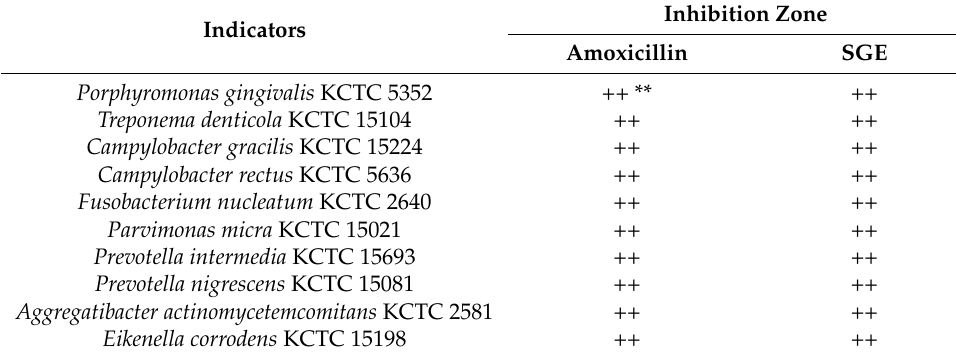
Table 2. Antimicrobial activity of SGE against periodontal pathogens. Indicators